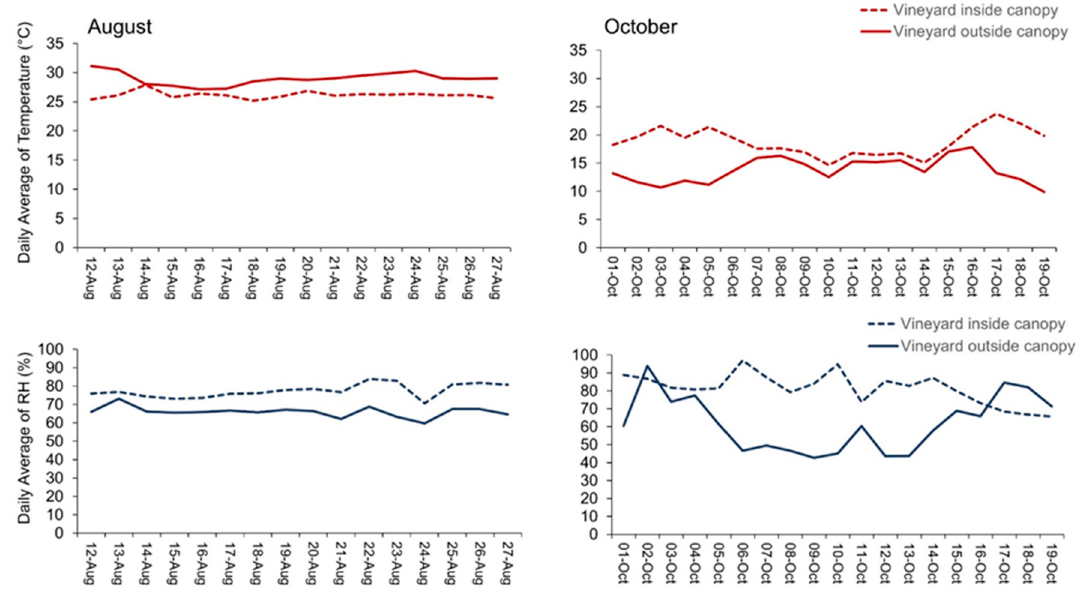
Figure 8. Daily average of temperature (°C) and relative humidity (%) recorded by agriLogger sensors positioned inside and outside a vineyard canopy in August and October.